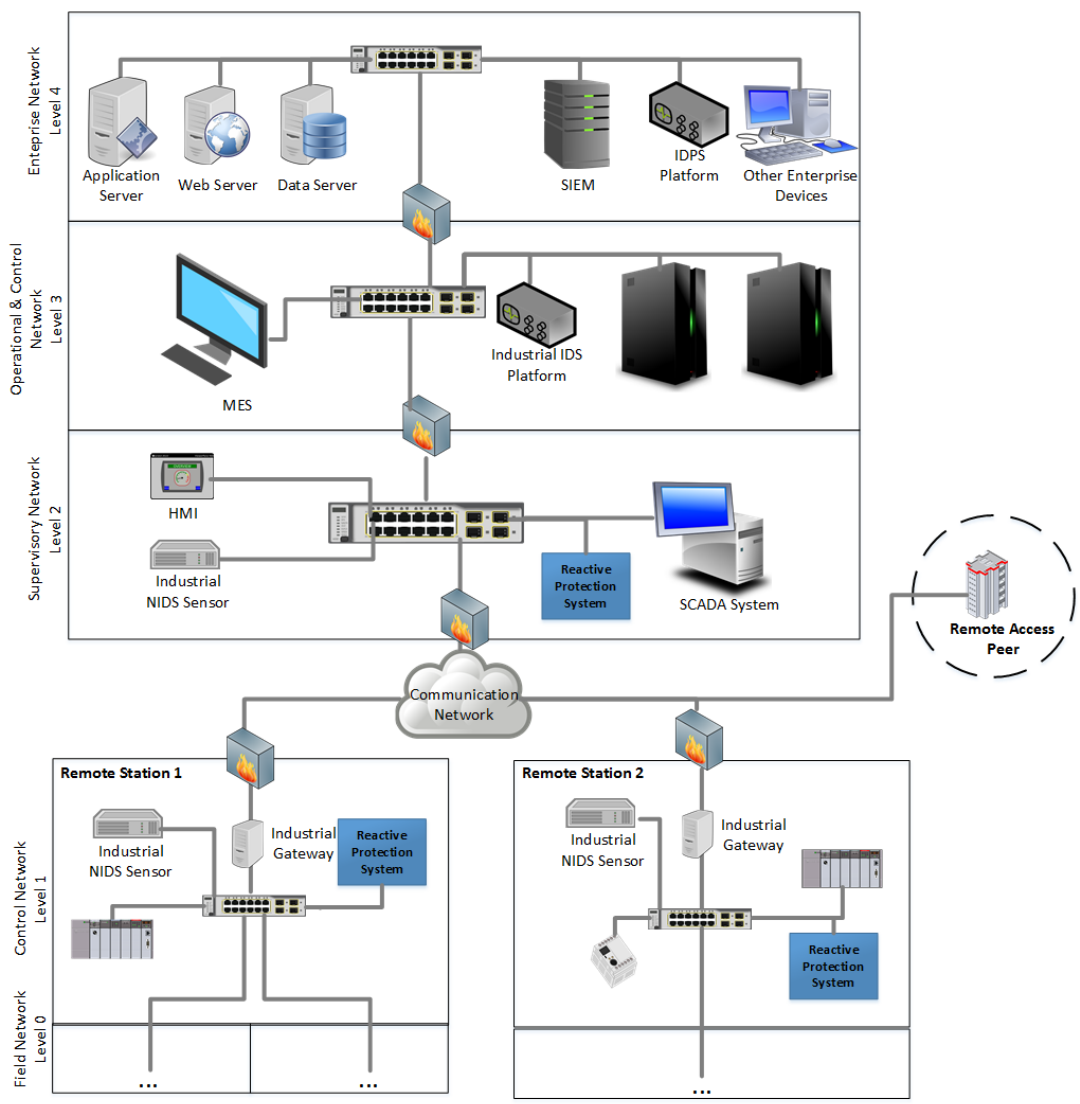
Figure 4. Extended Reference IAS Architecture (Figure 1) with remote access and security